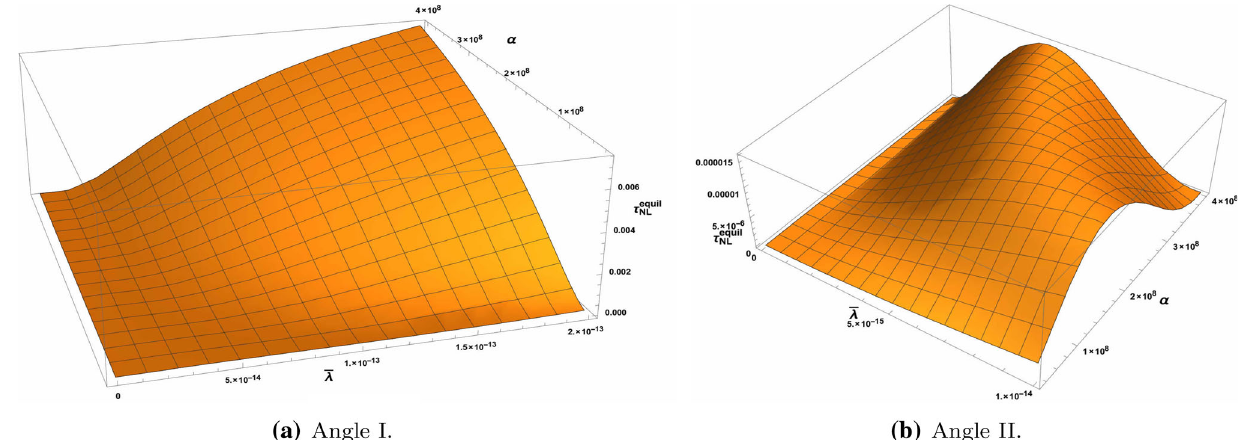
Fig. 19 Representative 3D diagram for equilateral non-Gaussian three point amplitude vs. the model parameters α and ¯ λ for N cmb = 60 in two different angular views